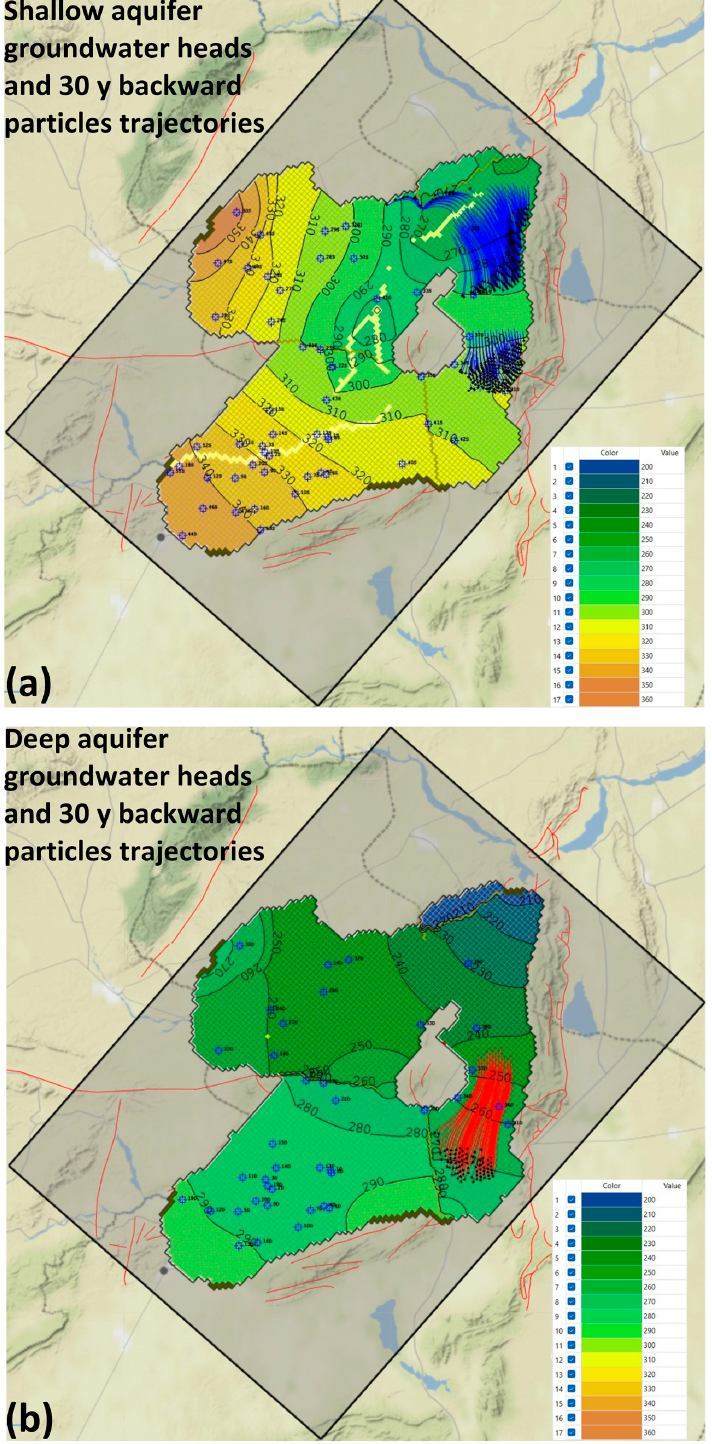
Figure 10. Contours of the calculated groundwater heads for the shallow ( a ) and deep aquifers ( b ). The backward particle trajectories from the zones with high NO 3 − concentration for the period 1990–2020, in blue for the shallow aquifer and red for the deep aquifer; black points delineate the NO 3 − source zones in